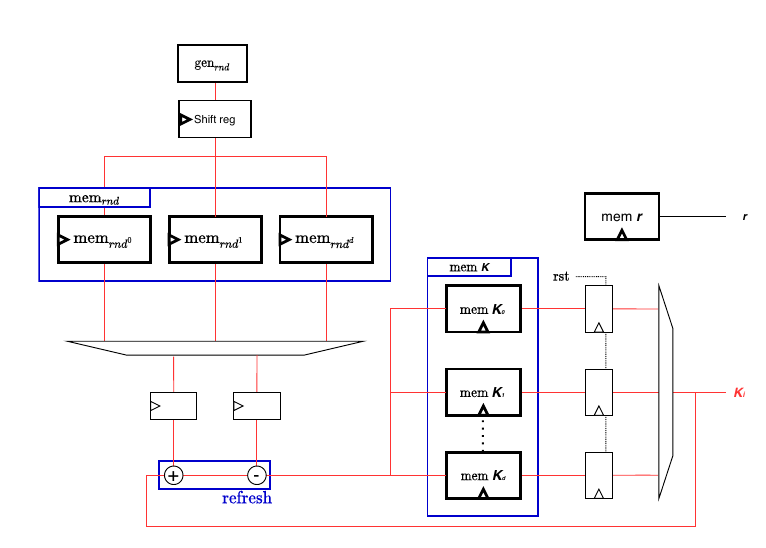
Figure 5: Architecture of the memory block.